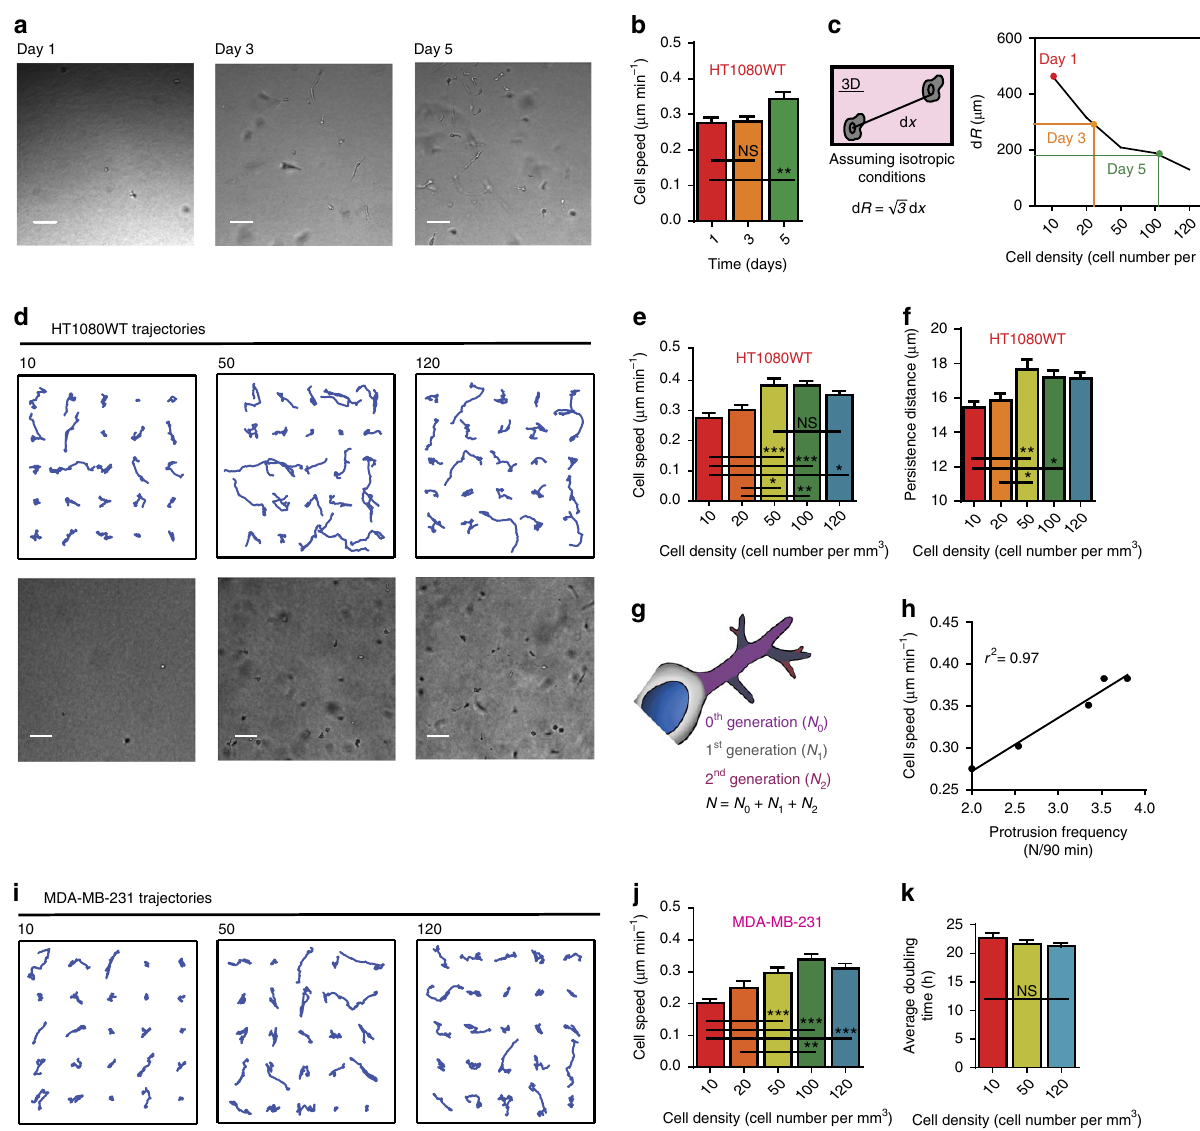
Figure 1 | Effect of cell density on cancer cell motility. ( a ) Phase contrast micrographs demonstrate confluence of human fibrosarcoma cells (HT1080WT) days after initial seeding. Scale bar, 100 m m. ( b ) Cell speed measured at a time lag of 2 min days after initial seeding. ( c ) Average distance to nearest cell (dR) relates density at different days to initial seeding density. ( d ) Randomly selected trajectories of human fibrosarcoma cells (HT1080WT) under different seeding densities of 10, 50, 120 cellsmm (cid:2) 3 embedded in a 3D collagen matrix. Phase contrast micrographs demonstrate the confluence at each density. Scale bar, 100 m m. ( e , f ) Cell speed and persistence distance measured at a time lag of 2min at different seeding densities. ( g ) Topology of protrusions for cells embedded in 3D collagen matrices: 0th generation protrusions (N 0 ) originate from the cell body, 1st generation protrusions (N 1 ) stem from N 0 and 2nd generation protrusions (N 2 ) stem from N 1 . ( h ) Cell speed and protrusion frequency are highly correlated. ( i ) Randomly selected trajectories of human carcinoma breast cancer cells (MDA-MB-231) under seeding densities of 10, 50, 120cellsmm (cid:2) 3 . ( j ) Cell speed evaluated at a time lag of 2min, at five different seeding densities. Cells at high seeding densities ( r 4 50) show a significantly higher speed than cells seeded at low seeding density ( r ¼ 10). ( k ) Average doubling time at increasing cell density demonstrates that proliferation is independent of cell density. In all panels, data is represented as mean ± s.e.m. from three independent experiments. * P o 0.05; ** P o 0.01; *** P o 0.001 (ANOVA) ( n ¼